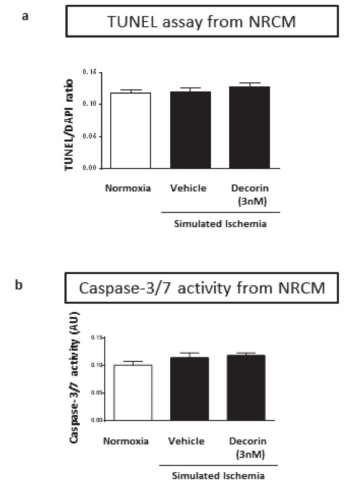
Figure 4. The e ff ect of 3 nM decorin on apoptosis in NRCMs exposed to SI / R. Results of ( a ) TUNEL assay and ( b ) Caspase assay. Data are normalized to vehicle-treated Normoxia and presented as